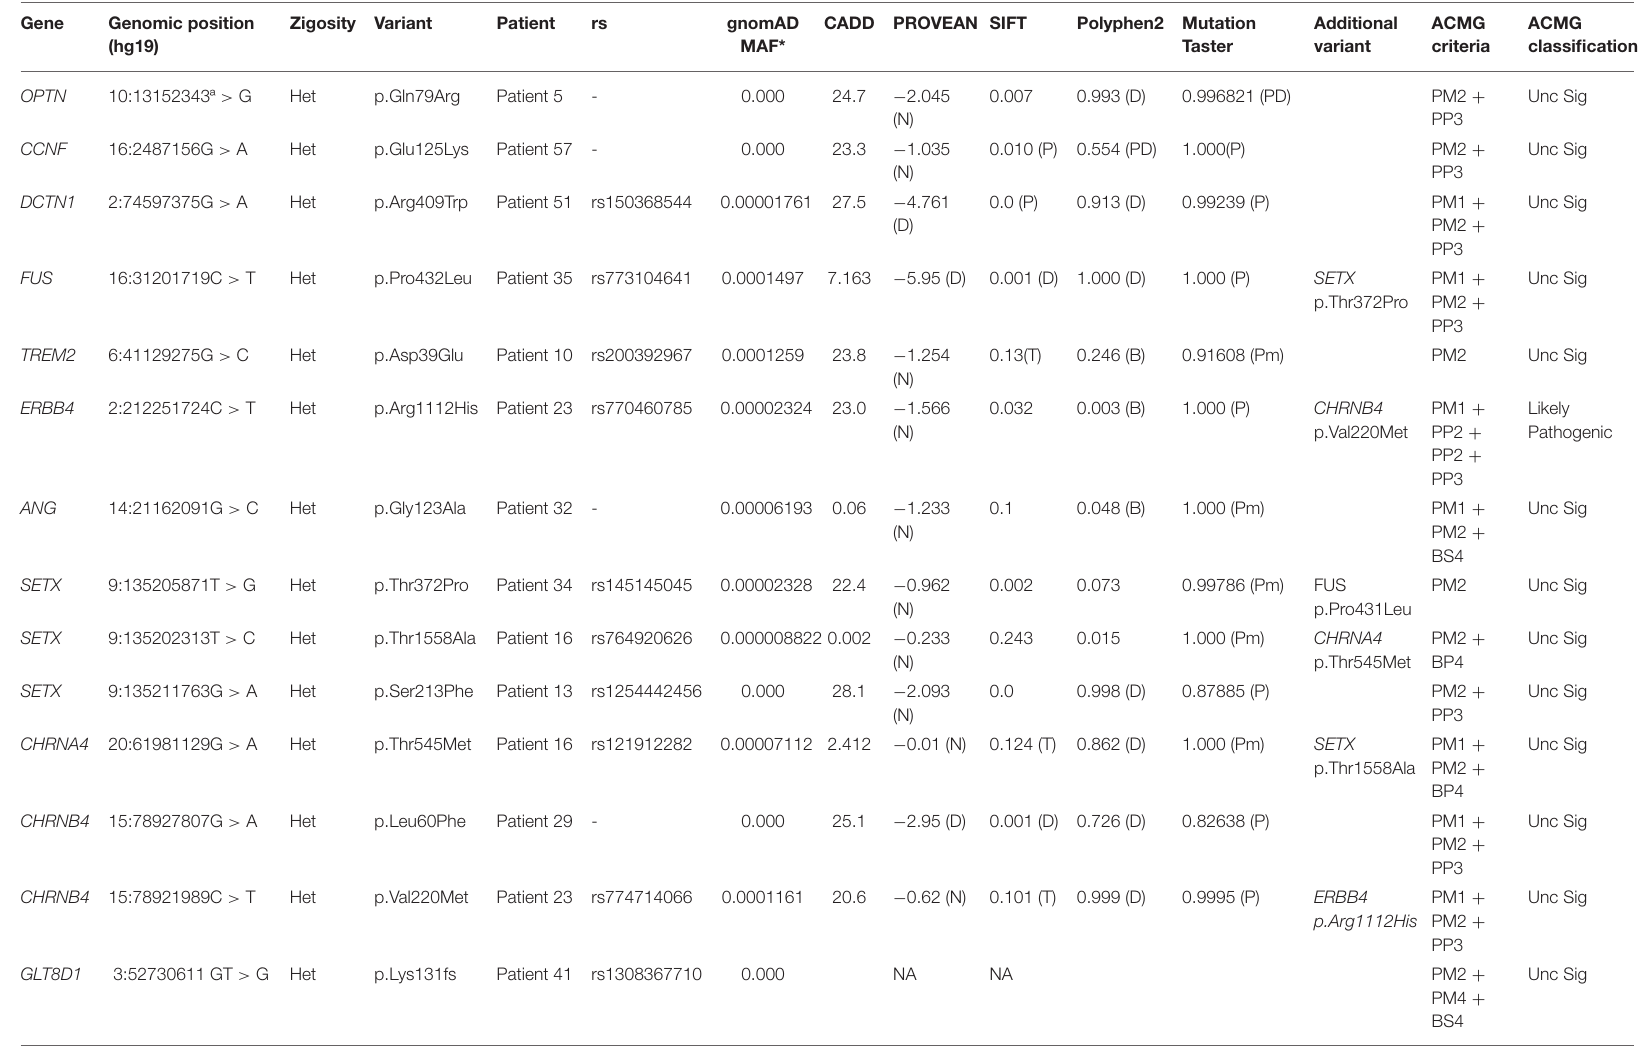
TABLE 1 | Rare variants identified in genes previously associated with Frontotemporal and/or Amyotrophic Lateral Sclerosis in the Portuguese cohort of Frontotemporal